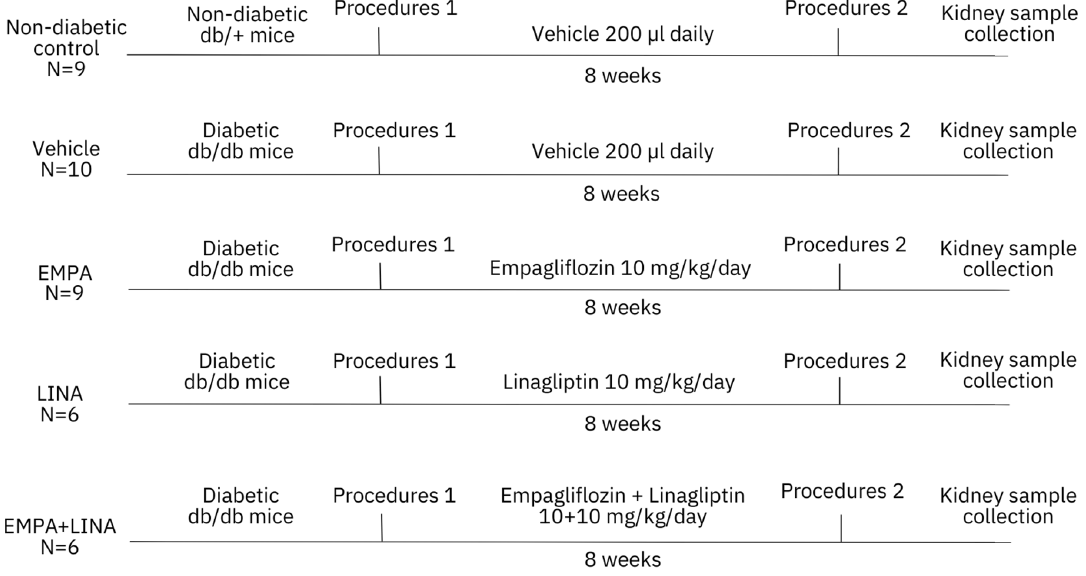
Figure 7. Flowchart of the study. The experiment was started with 8-week-old non-diabetic db+